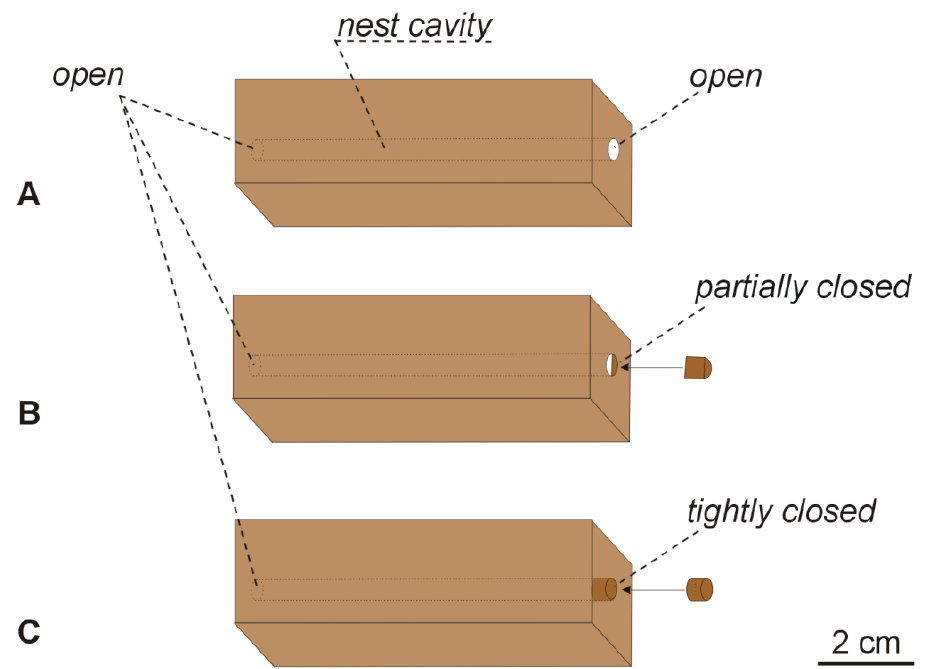
Figure 1. Nest designs of the artificial nest sites used during the field experiments. Three types of nest sites were used: ( A ) ‘open’—woodblock drilled lengthwise to form a 4 mm hole, where the hole was not closed; ( B ) ‘partially closed’—a hole was partially closed on one side with a beech plug; ( C ) ‘with one side closed’—a hole was fully closed on one side with a beech plug. The cavity volume was approximately 0.9 cm 3 .